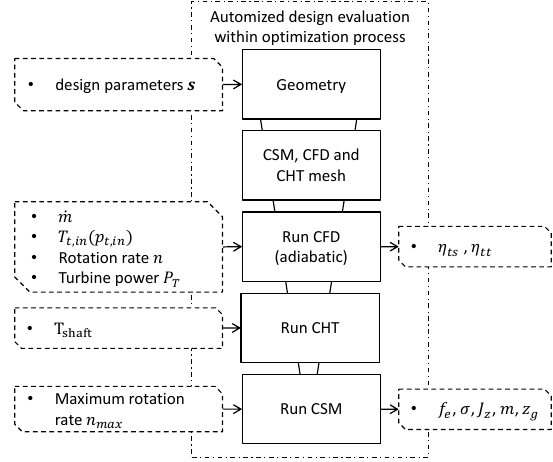
Figure 1. Gradient-free